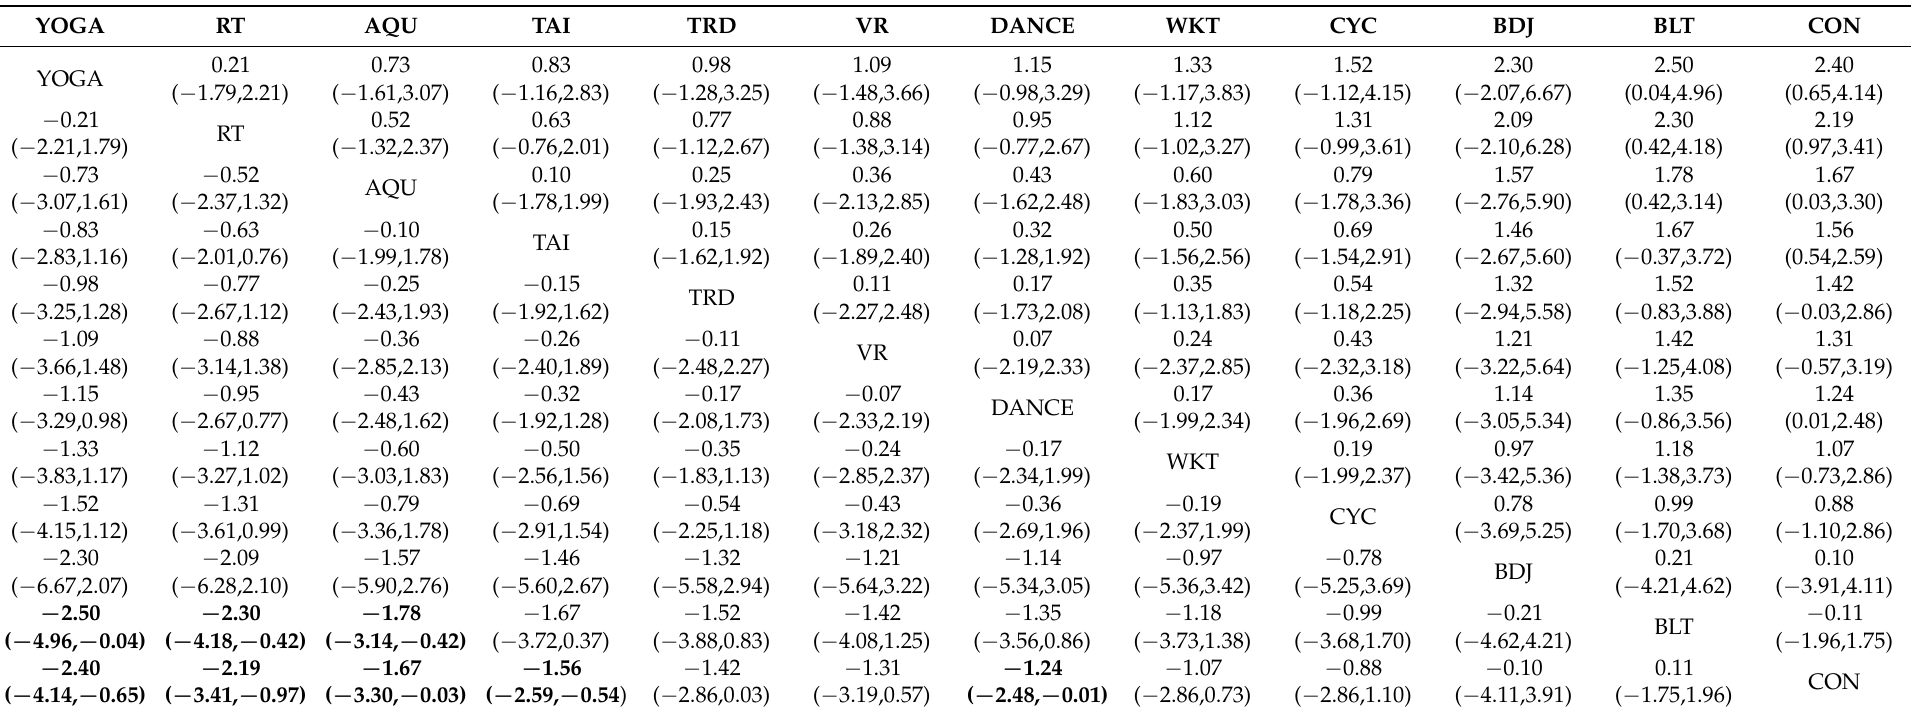
Table 4. League table on